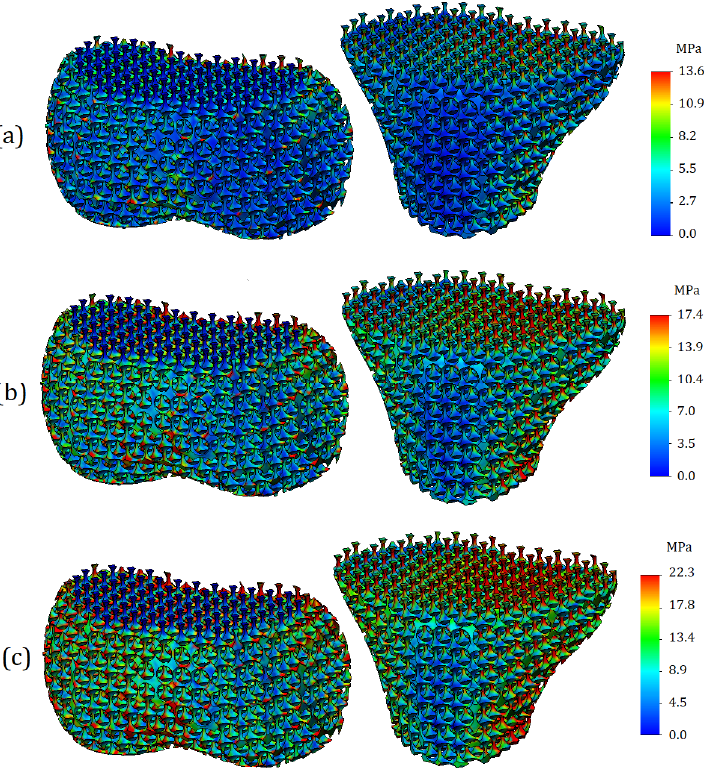
Figure 13. Von Mises stress plots on trabecular bone in case of running: ( a ) With mild cartilage sti ff ness; ( b ) With moderate cartilage sti ff ness; ( c ) With severe cartilage sti ff ness.